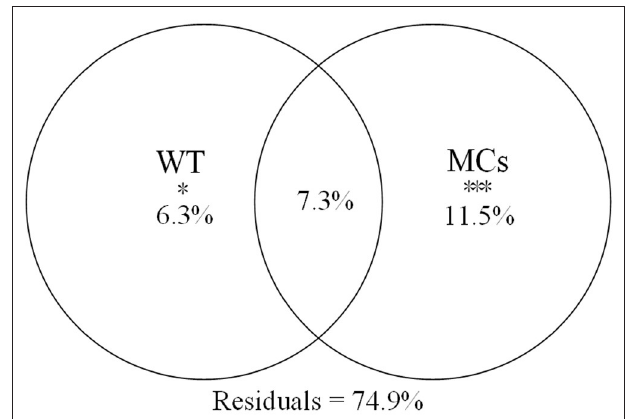
FIGURE 6 | Variance partitioning plot of gut microbial community of B. aeruginosa . * P < 0.05, *** P < 0.001.